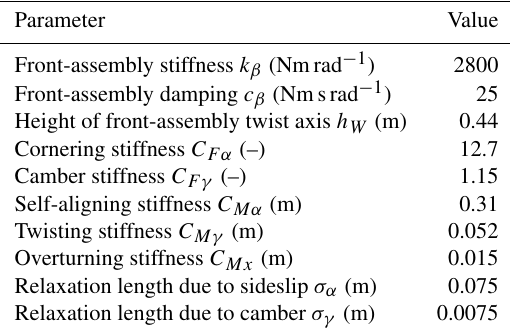
Table 1. Tire and fork